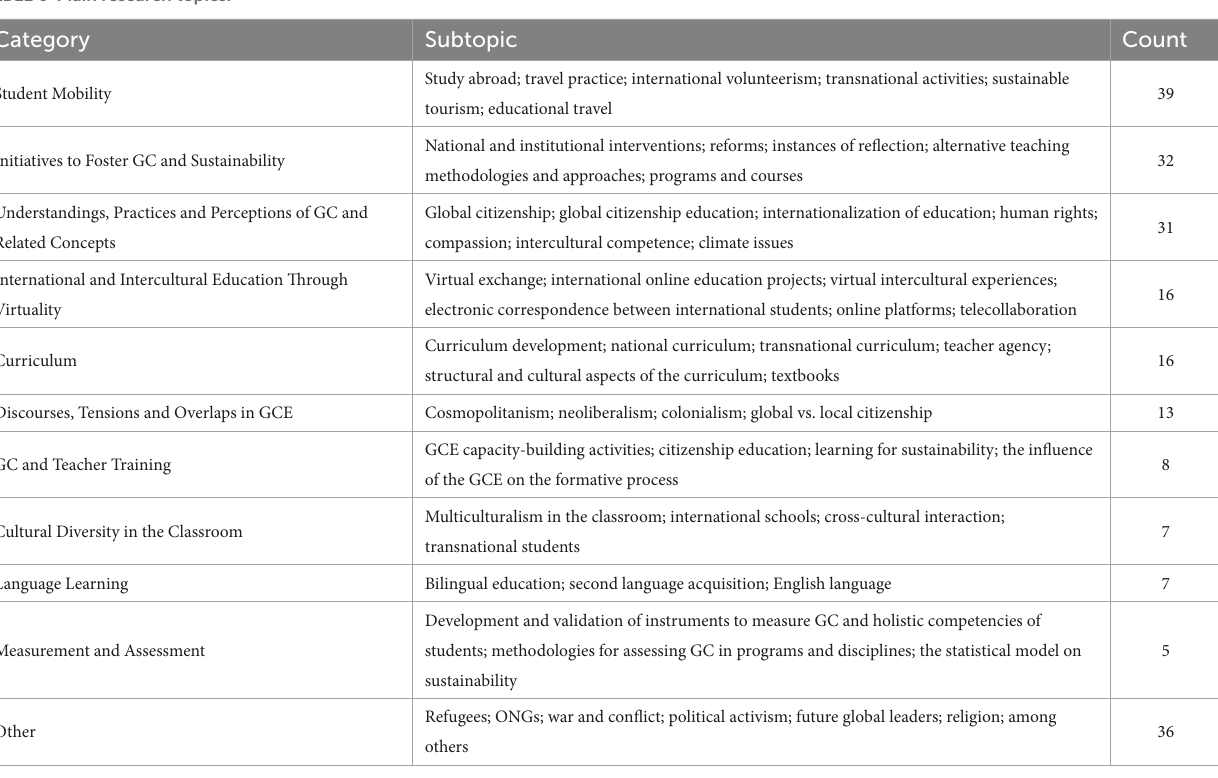
TABLE 6 Main research topics.